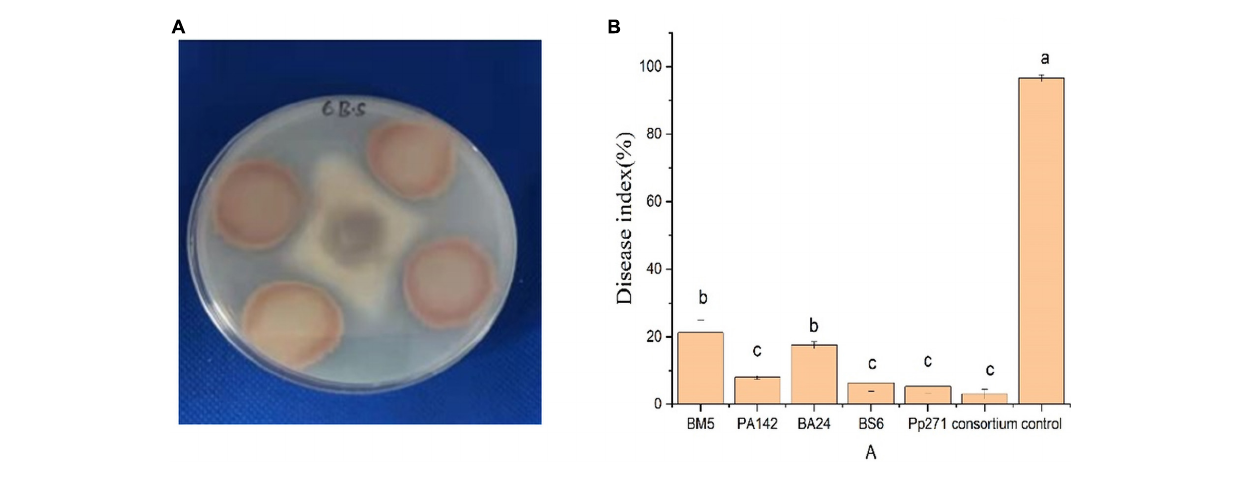
main driver of this dysbiosis (Chen et al., 2020). Dysbiosis of microbiota communities can also trigger loss predicted community functioning module based on metagenomics analysis